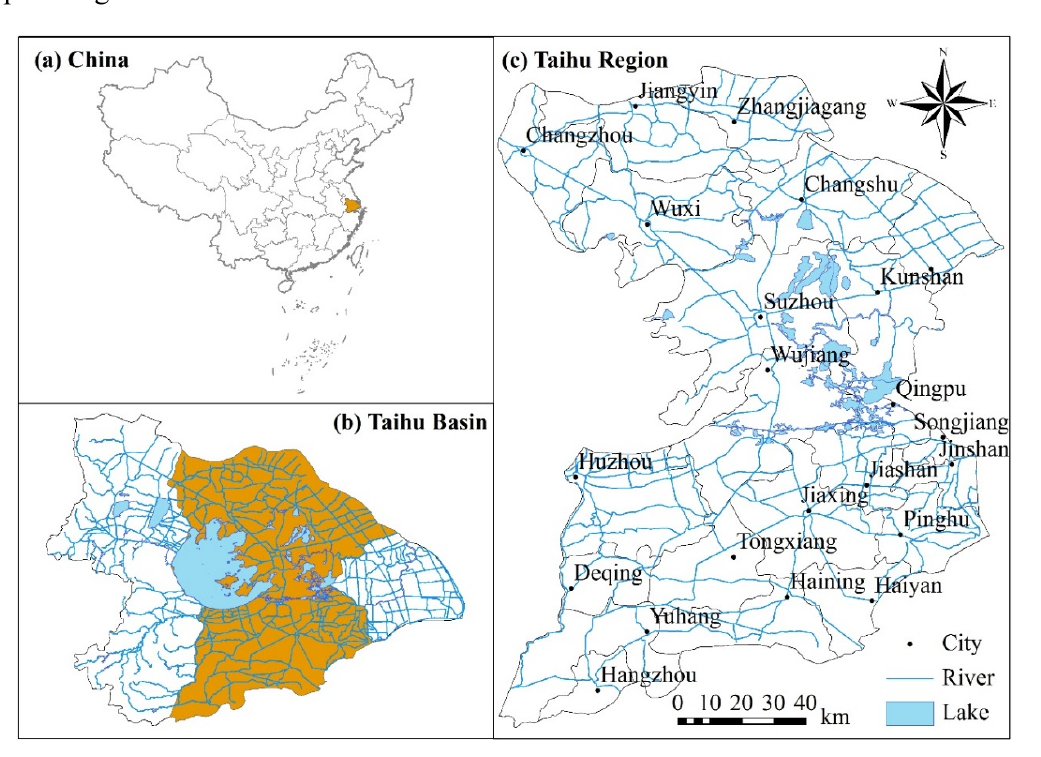
Figure 1. The map of Taihu